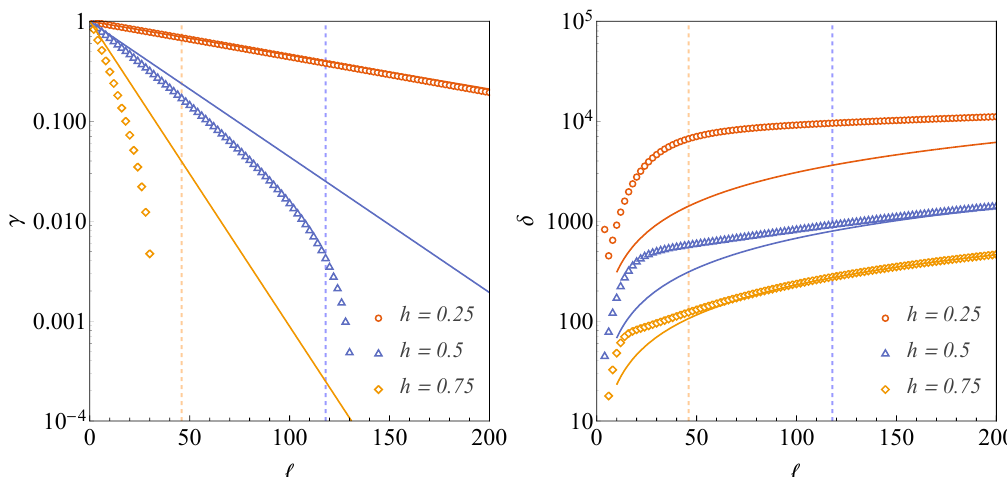
Figure 10: Logarithmic plot of the best fit parameters { γ , δ } (symbols) when using Eq. (80) to approximate the behaviour of the exact stationary PDF obtained in Sec. 4.1.2. Vertical dashed lines represent (cid:96) ∗ (cid:39) { 118, 46 } respectively for h = { 0.5, 0.75 }